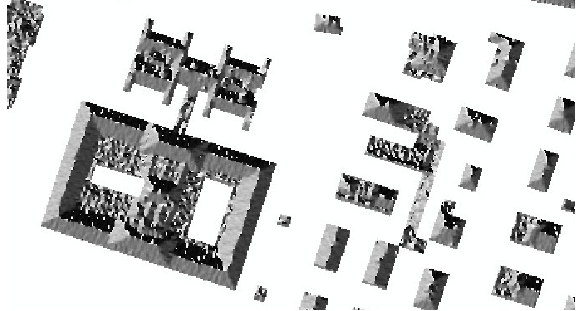
Figure 12: Aspect Map generated from DSM masked with Mu- nicipality